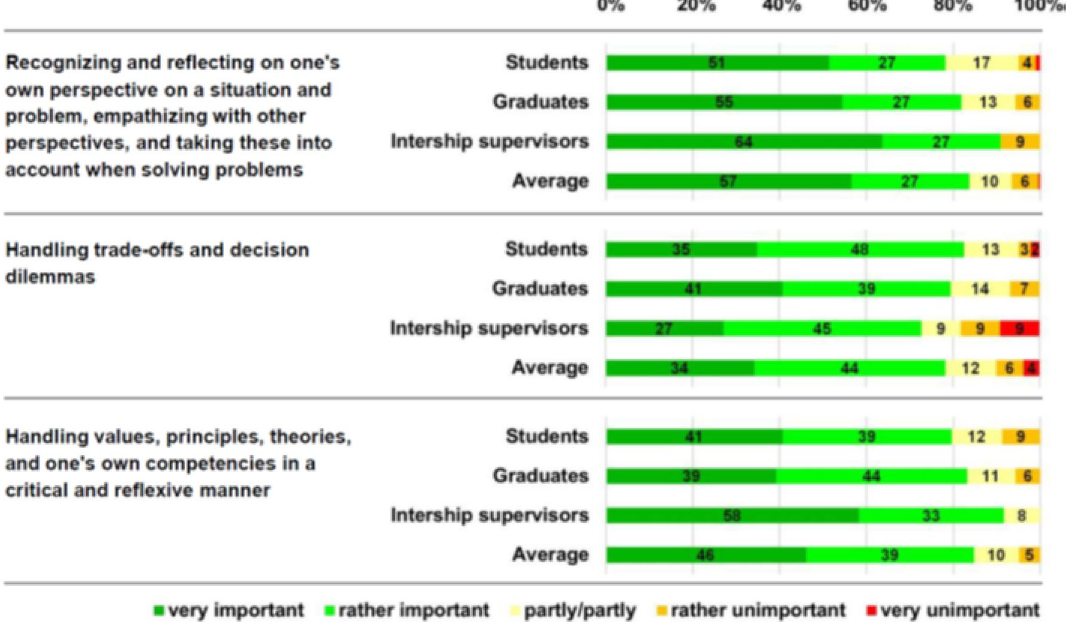
Fig. 2 Assessment regarding the importance of fostering personal competencies from the perspective of students, graduates, and internship supervisors, as well as the average of the three estimations in % (students are N = 101/103/103 from top to bottom; graduates N = 88/88/89; and internship supervisors N =